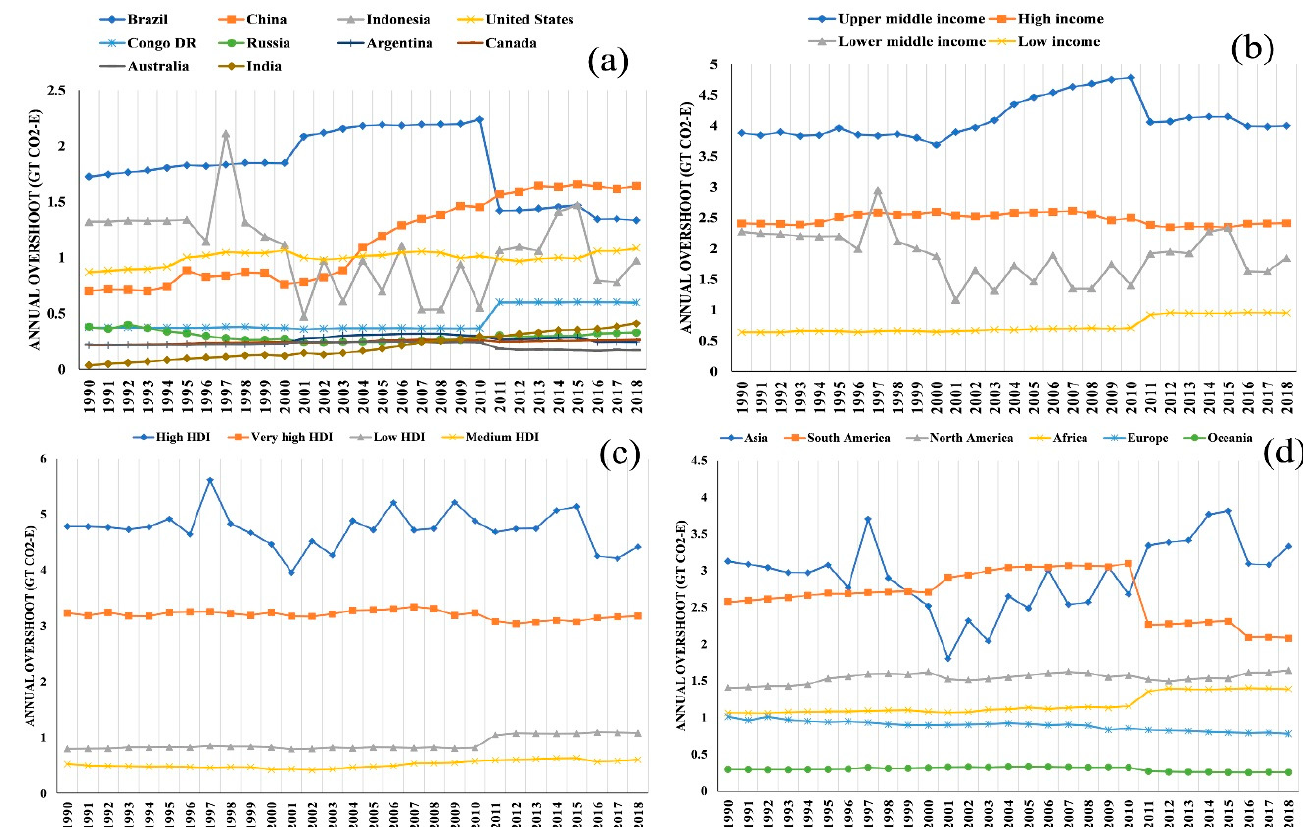
Figure 2. Annual overshoot of national or regional fair share of GHG emissions from food systems (1990–2018). Annual overshoots from ( a ) 10 countries, ( b ) four income groups (as per World Bank), ( c ) four HDI categories (as per HDR, 2020), and ( d ) six continents. Foods 2022 , 11 , x FOR PEER REVIEW